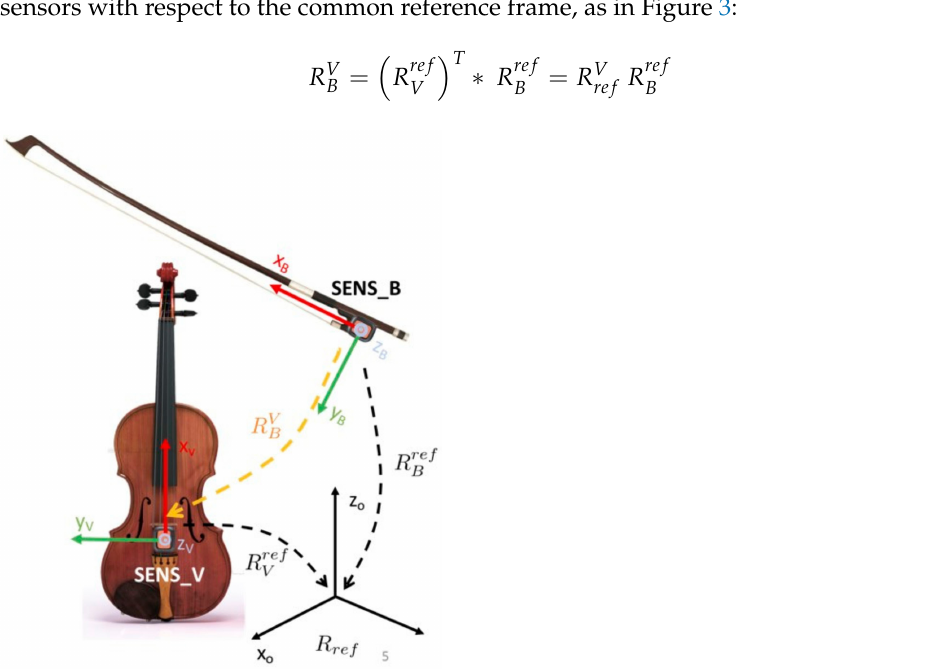
expresses the orientation of the V expresses the orientation of the B